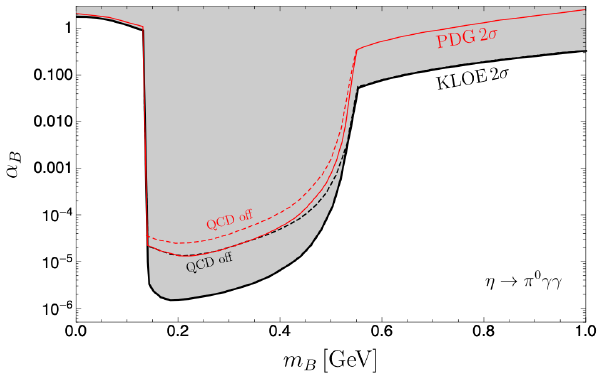
Figure 1. Limits on the leptophobic B -boson coupling α B for di ff erent m B masses from the η → π 0 γγ BR measurements by KLOE [6] (black line) and the PDG [8] (red line). The grey shaded region is excluded by KLOE and the dashed lines correspond to the limits with the QCD contributions turned o ff .